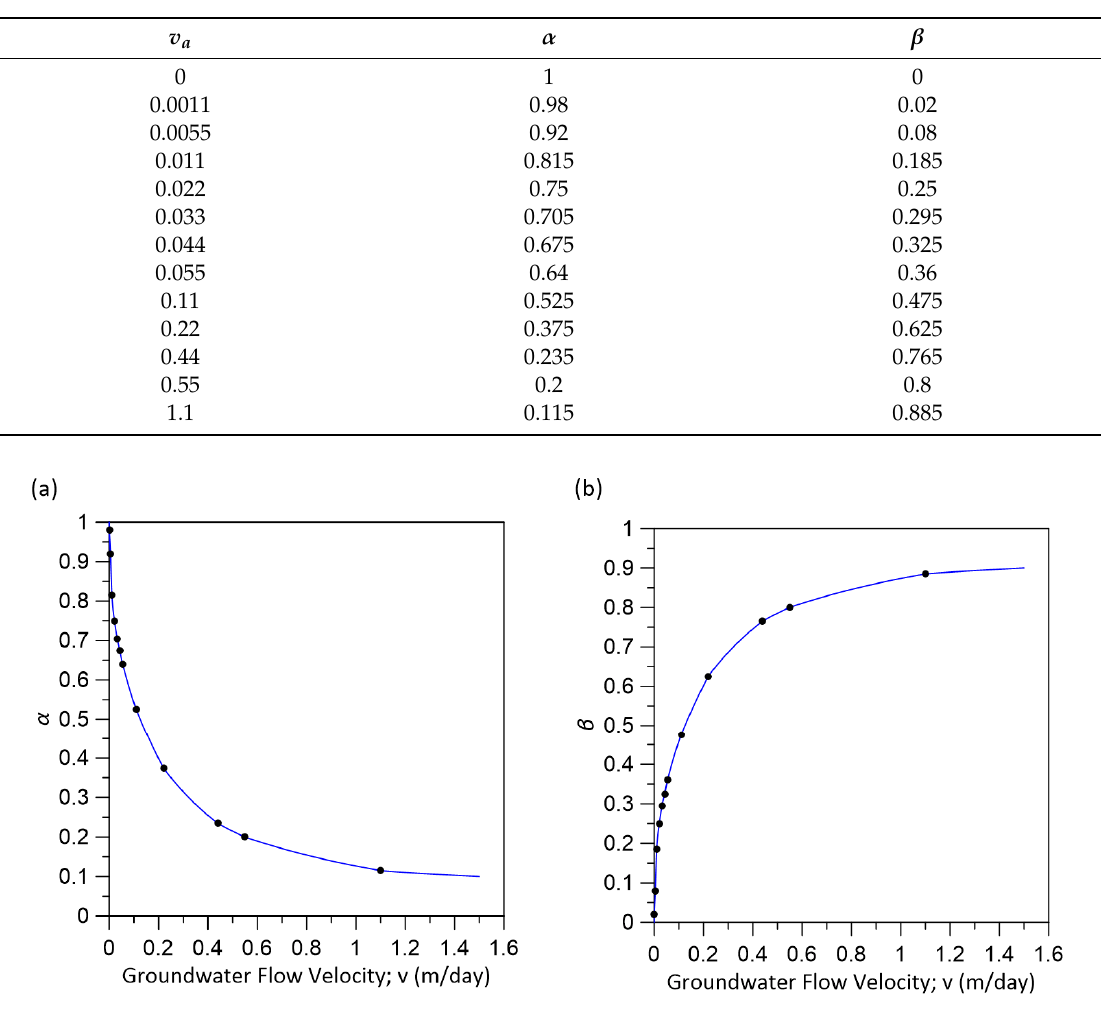
Figure 7. Relationship between arithmetic average groundwater flow velocity and ( a ) parameters α and ( b ) β .